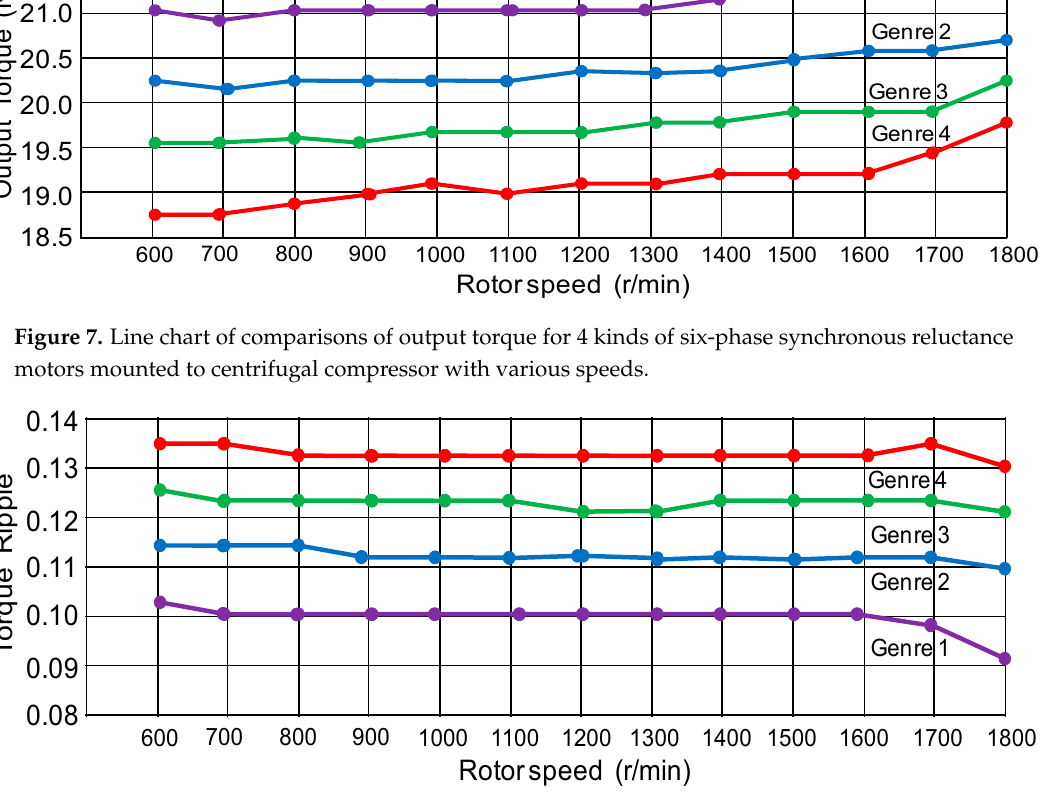
Figure 8. Line chart of comparisons of torque ripple for 4 kinds of six-phase synchronous reluctance motors mounted to centrifugal compressor with various speeds.